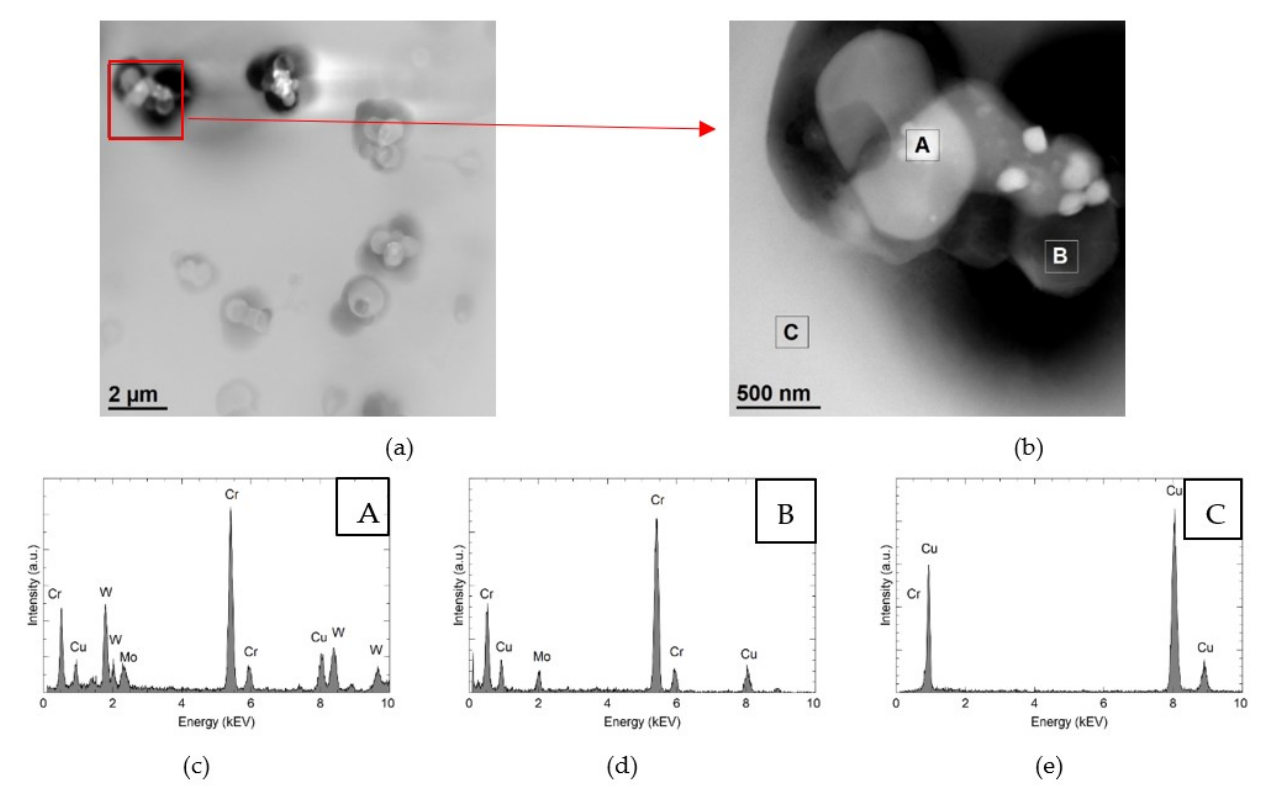
Figure 8. Structure of precipitates containing W and Cr in the sample Cr50WC50. HAADF images ( a , b ). Results of the chemical composition analysis in the areas marked A ( c ), B ( d ) and C ( e ).